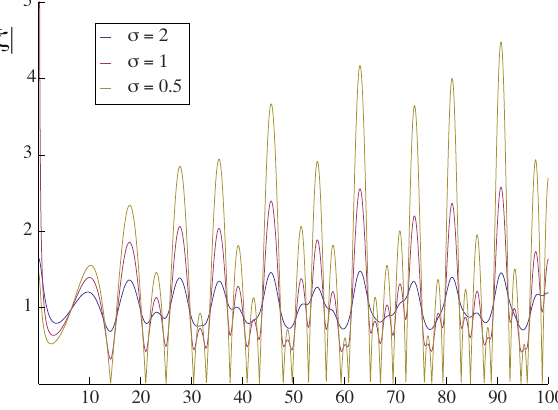
Figure 9. | ζ ( σ + it )| = for σ ∈ {1/2, 1, 2}, 0 < t <